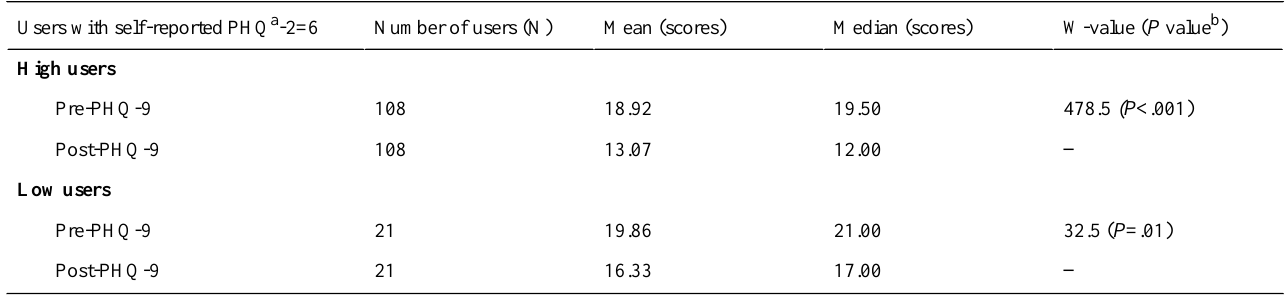
Table 1. Within-group analysis.